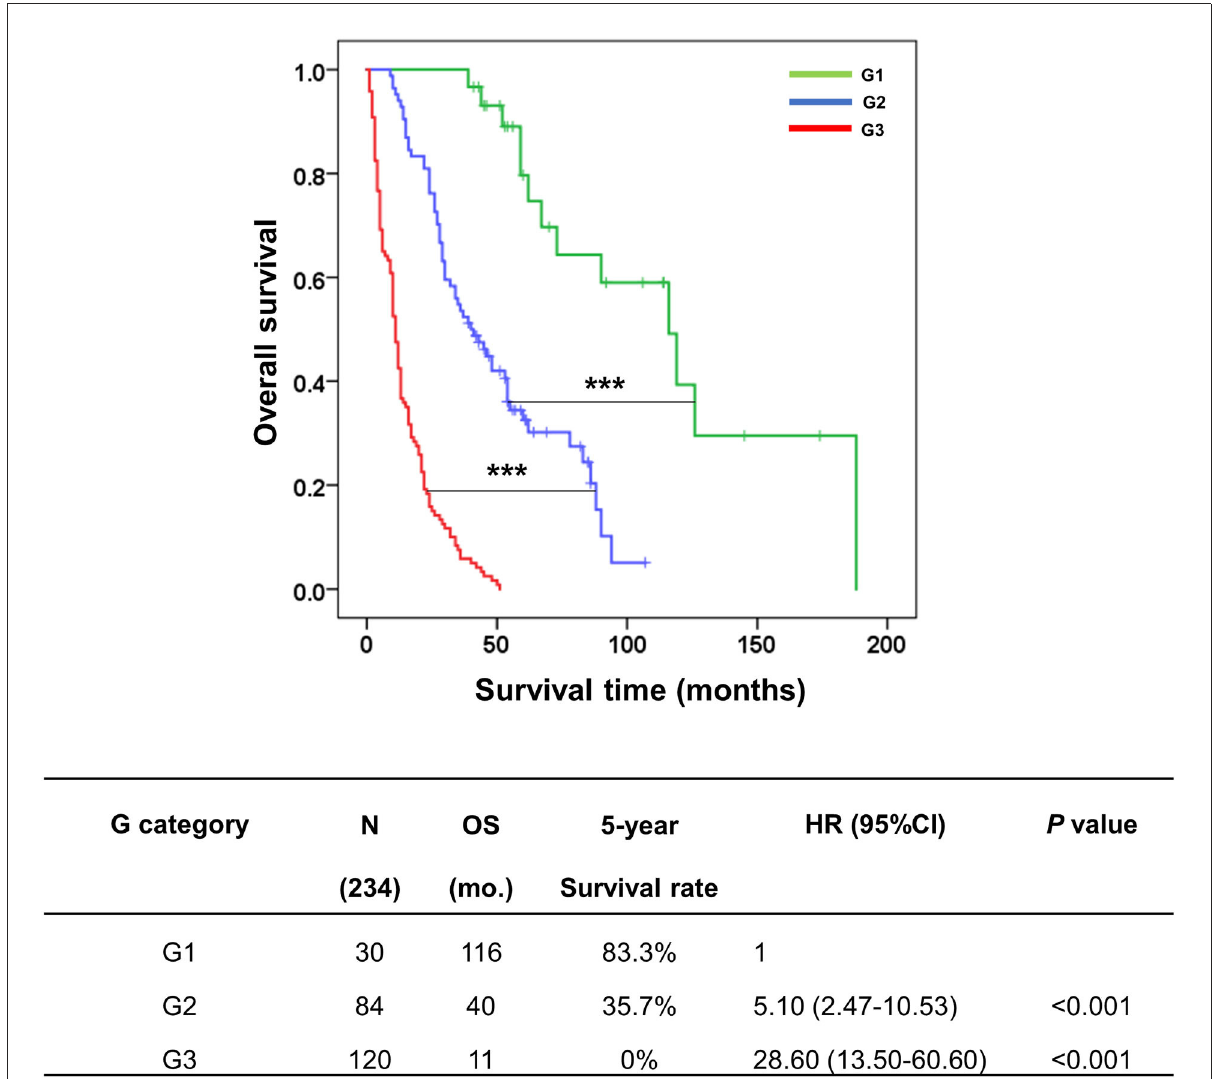
FIGURE6 Kaplan–Meier curve represented the overall survival of the G category in the KKU staging system for classifying patients with perihilar cholangiocarcinoma. The table represented the outcomes of patients with G category classification, namely, groups, number of cases, overall survival, 5-year survival rate, hazard ratio, and p -value. *** p <